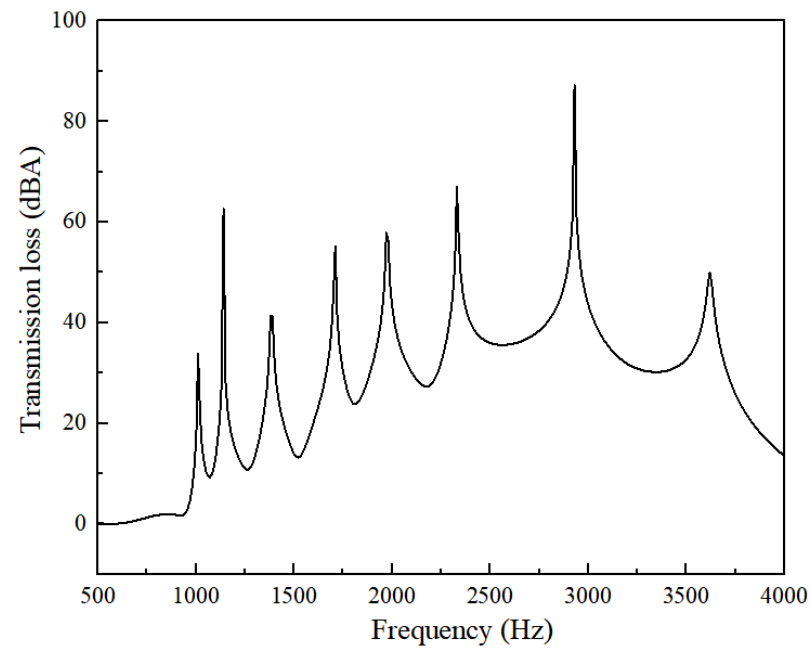
Figure 25. Transmission loss of the perforated muffler.